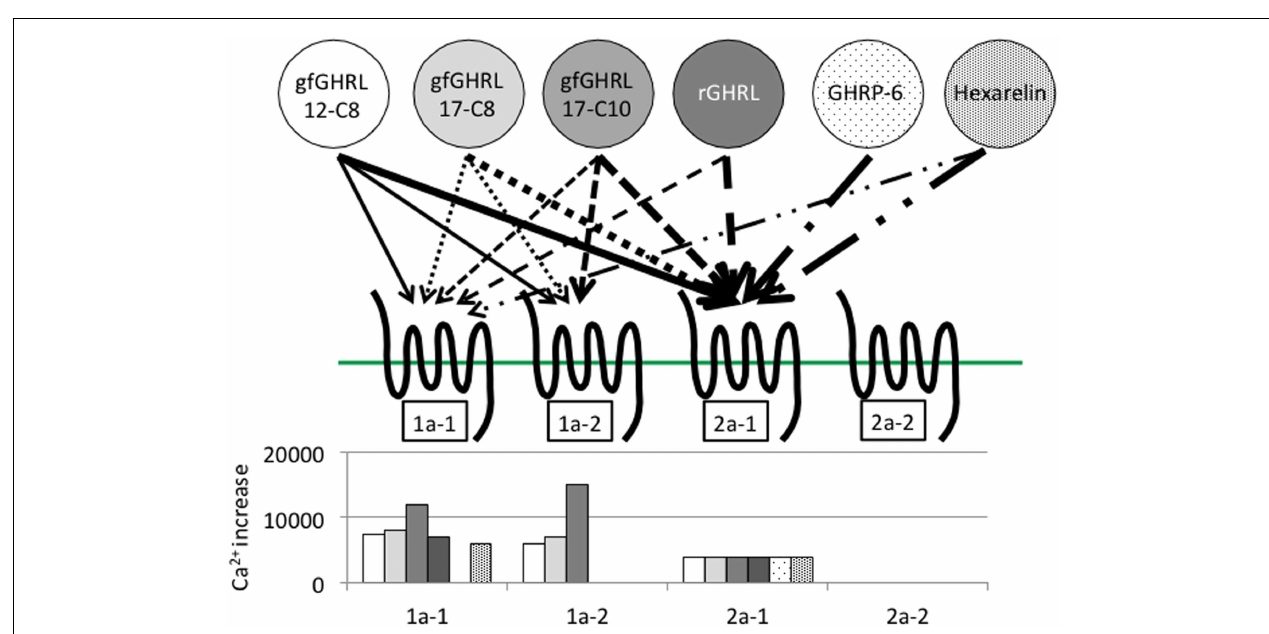
GHSs, GHRP-6 and hexarelin, were used in the experiment. For example, the arrows indicate that the intracellular Ca 2 + increased in cells expressing GHS-R1a-1 after exposure to gfGHRL12-C8, 17-C8, and 17-C10; rat ghrelin; and hexarelin, but not after exposure to GHRP-6 at a similar dose.The corresponding bar graph shows that gfGHRL17-C10 increased Ca 2 + much more strongly than the other agonists. Furthermore, although GHS-R2a-2 was capable of binding all of the agonists examined at a low dose, none of the agonists increased the intracellular Ca 2 +